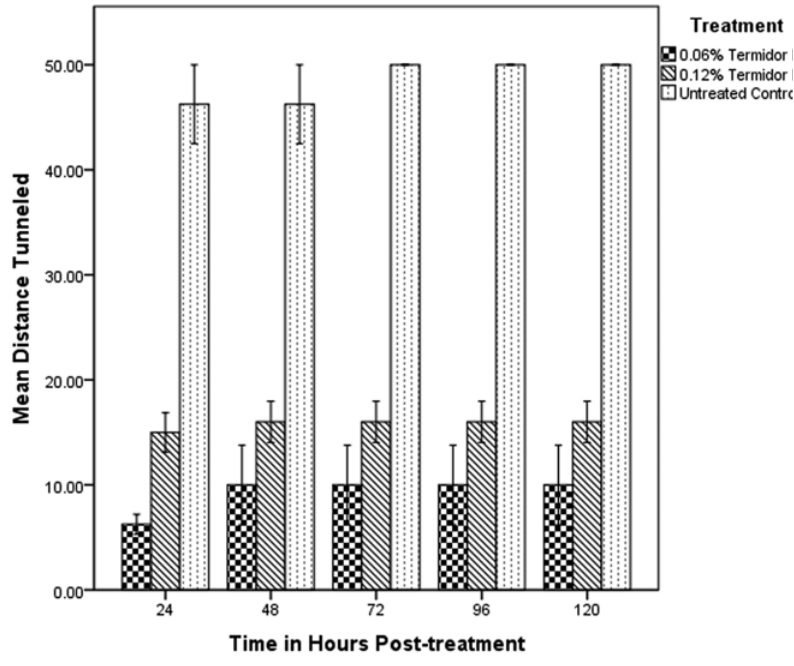
Fig. 4 . Mean distance tunneled (mm) by Coptotermes formosanus in a glass tube bioassay through time in soils treated with Termidor ® HE (maximum distance tunneled could not exceed 50